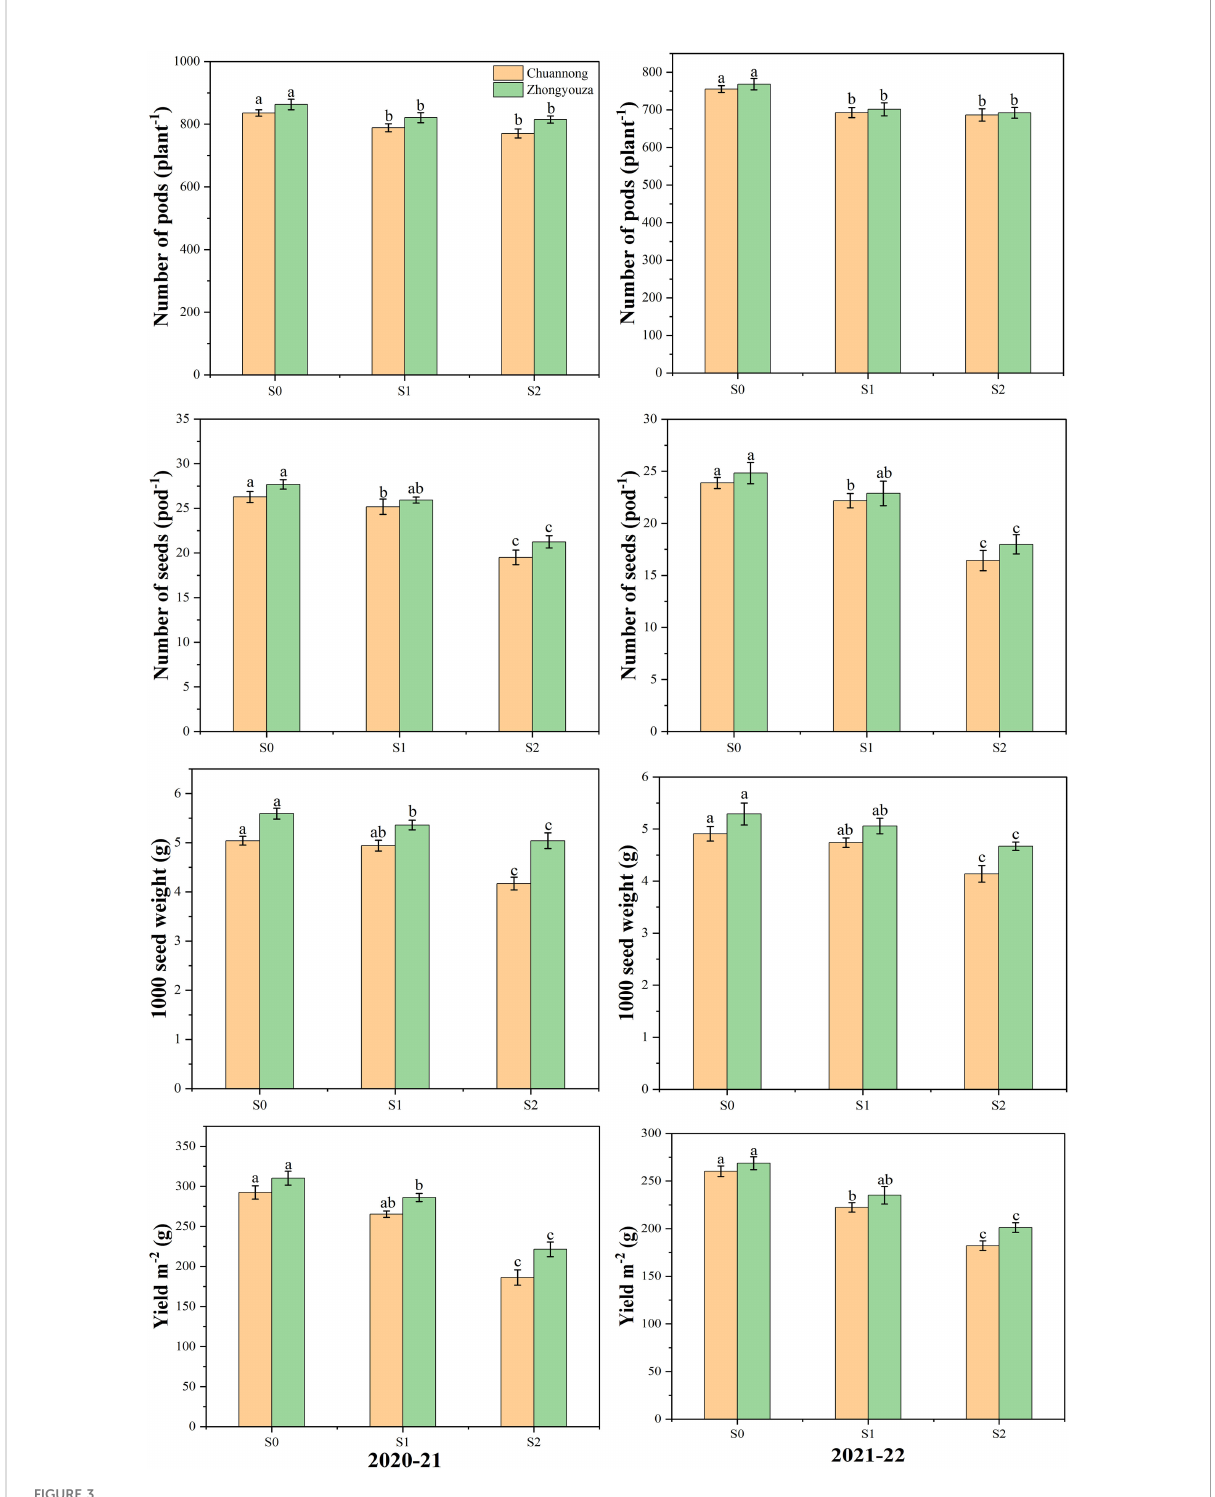
FIGURE 3 Effect of shading on yield parameters of rapeseed. S0= control (ambient light); S1= shade at the whole fl owering stage and S2= shade at the start of pod development to pod maturity. Values were determined using the (n=10) LSD test, and various small letters denote the signi fi cance level of treatments at the 0.05 probability level (Duncan